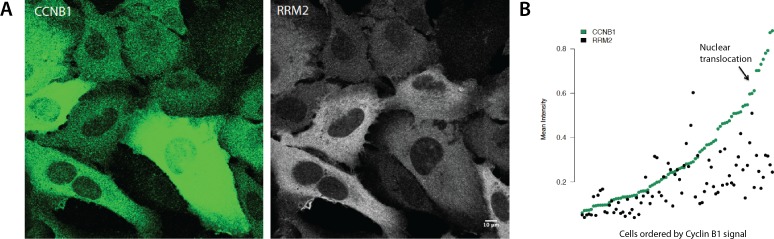
RRM2 abundance decreases during early mitosis in U2OS cells.Anti-Cyclin B1 and anti-RRM2 signals were measured in U2OS cells by immunofluorescence microscopy. Representative images of cyclin B (A, left) and RRM2 (A, right) staining. (B) Quantitation of immunofluorescence with cells ranked ordered based on Cyclin B1 signal. The arrow indicates nuclear concentration of Cyclin B1 signal, which marks mitotic entry.